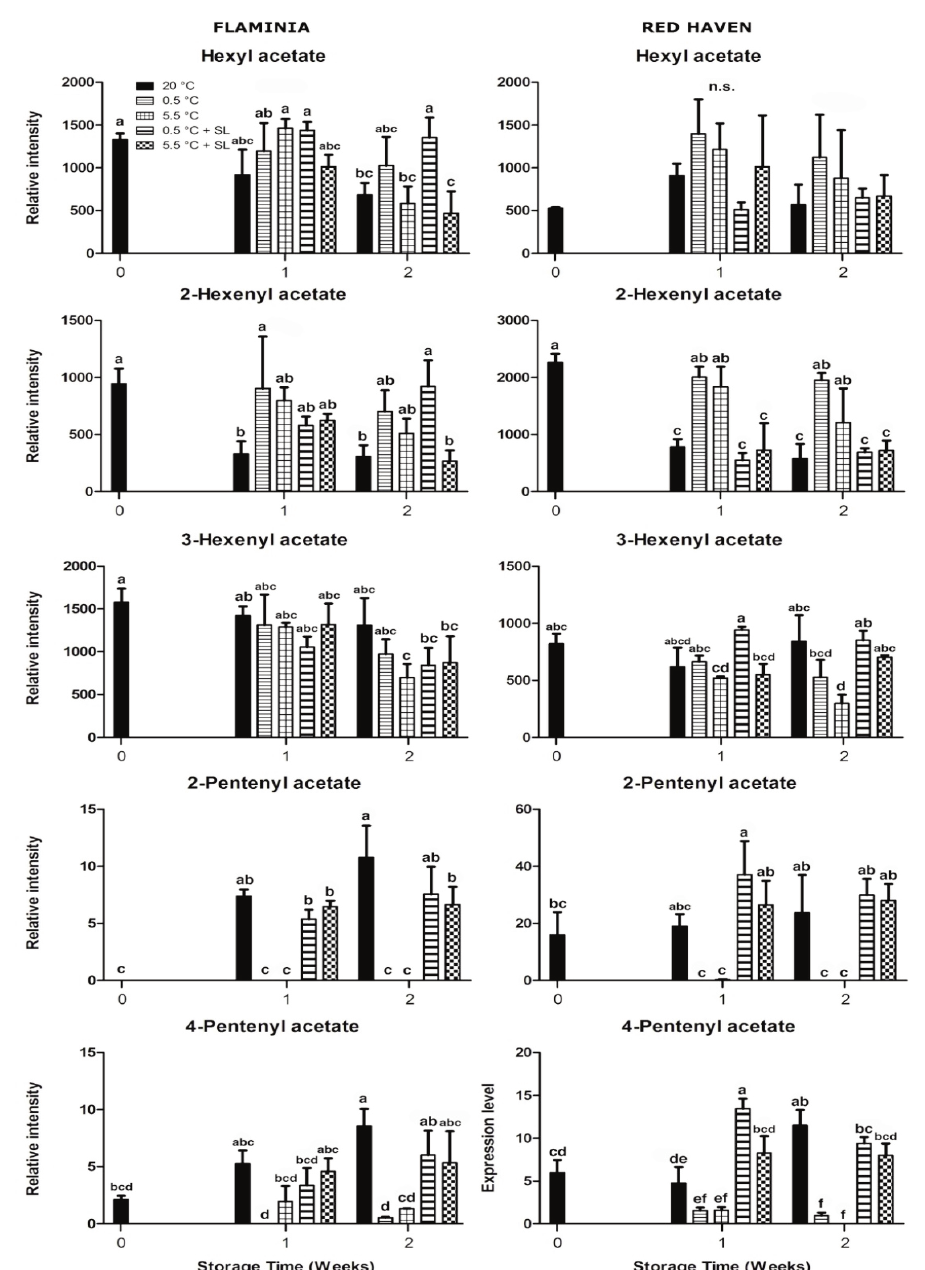
Fig. 3 ­ Analysis of targeted LOX pathway­derived esters. Mesocarp samples (cv. Flaminia, left panel; cv. Red Haven, right panel) were analysed at harvest (0), at the end of 1 and 2 weeks of cold storage at 0.5 and 5.5°C, and after three additional days of shelf life (0.5 and 5.5°C + SL). Samples kept at 20°C represent the room temperature control. The average value of three biological replica­ tes is reported with bars representing SD. Letters indicate the results of Tukey's Honest Significant Difference (HSD) post hoc test, performed independently for each